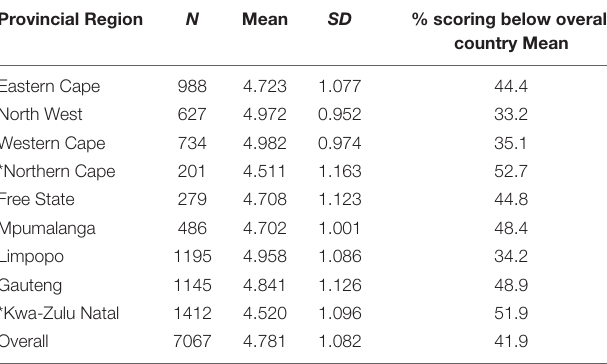
TABLE 3 | Mean scores and percentage of the sample scoring below the overall